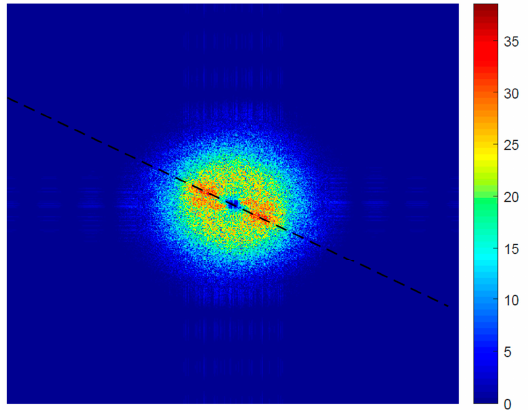
Figure 3. Wavelet coe ffi cient 2DFT of the SAR image